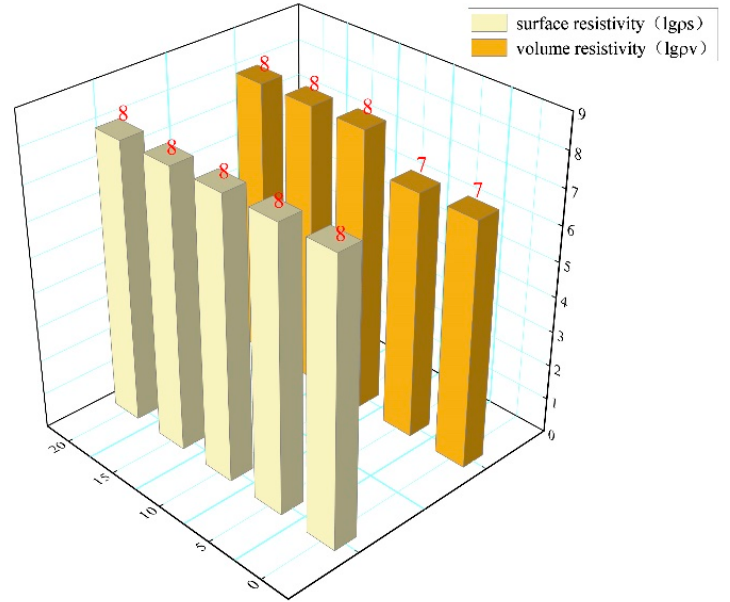
Figure 3. Effect of different APP/ZB content on antistatic properties of FWPC. Figure 3. E ff ect of di ff erent APP/ZB content on antistatic properties of FWPC.